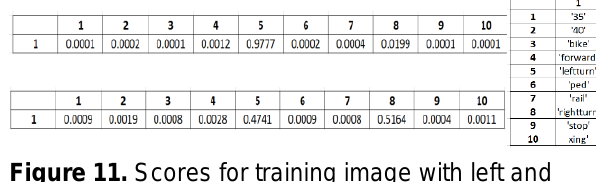
Figure 11. Scores for training image with left and right arrow, Colour CNN (top) vs Raw CNN (bottom) & Class number (right) Table 3. CNN names and descriptions